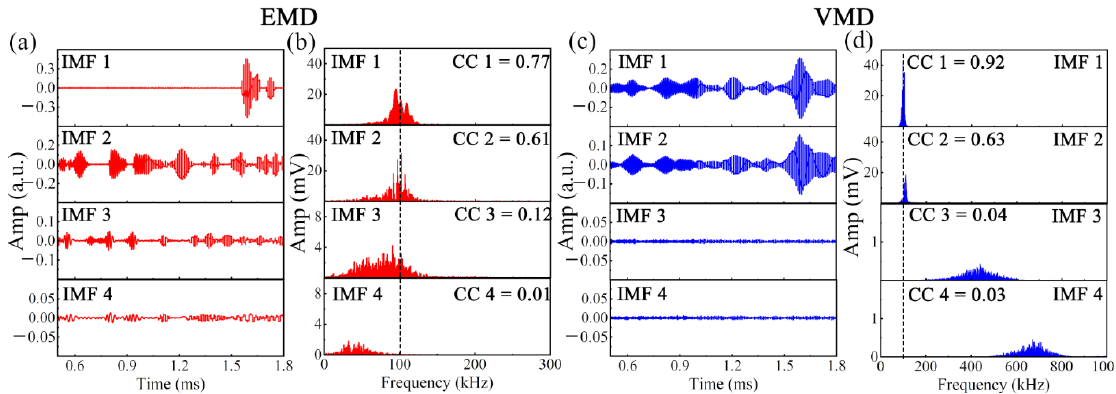
Figure 14. Experimental UGW signals: ( a ) EUS 1, ( b ) EUS 2, ( c ) EUS 3, and ( d ) EUS 4.